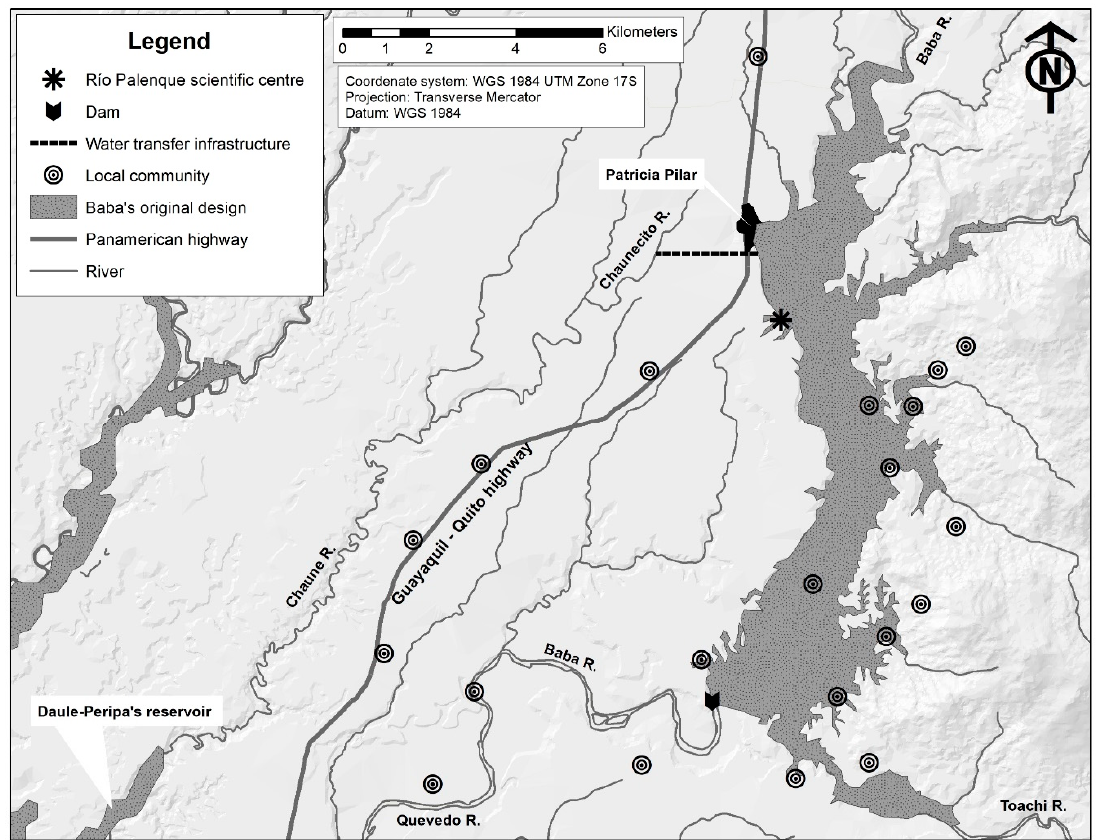
Figure 1. Baba dam’s original design and main affected local communities. Source: HidroPacífico S.A.